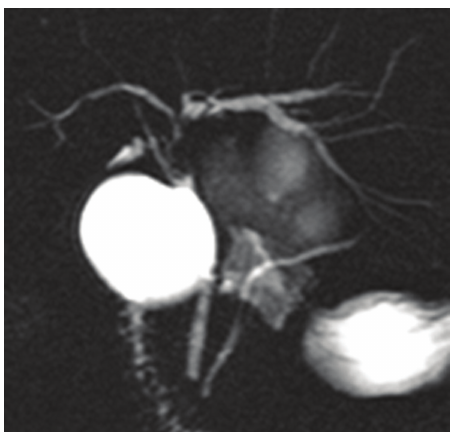
Figure 1: Axial T1 after gadolinium. Cyst in the segment IV of the liver with a thick enhanced wall (arrow).